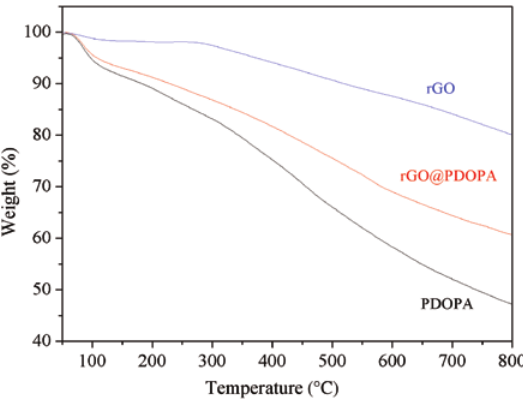
Figure 4: TGA traces of rGO, PDOPA and rGO@PDOPA.